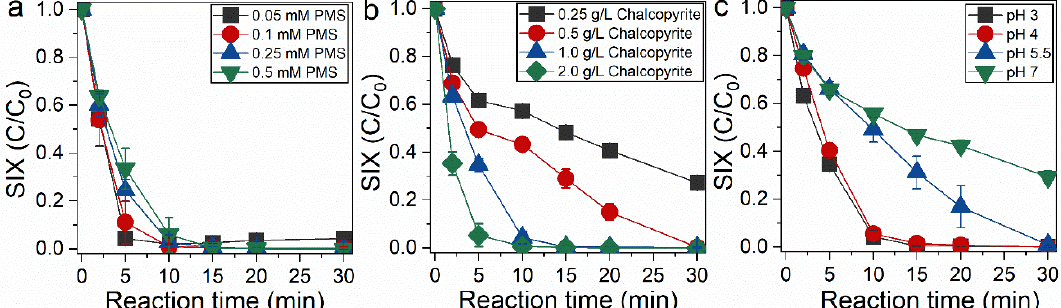
Figure 2. Effects of ( a ) PMS, ( b ) chalcopyrite, and ( c ) solution pH values on the degradation of SIX by chalcopyrite–PMS oxidation. Conditions: [SIX] = 5 mg/L, ( b , c ) [PMS] = 0.5 mM, ( a , c ) [chalcopy- rite] = 1 g/L, and ( a , b ) pH